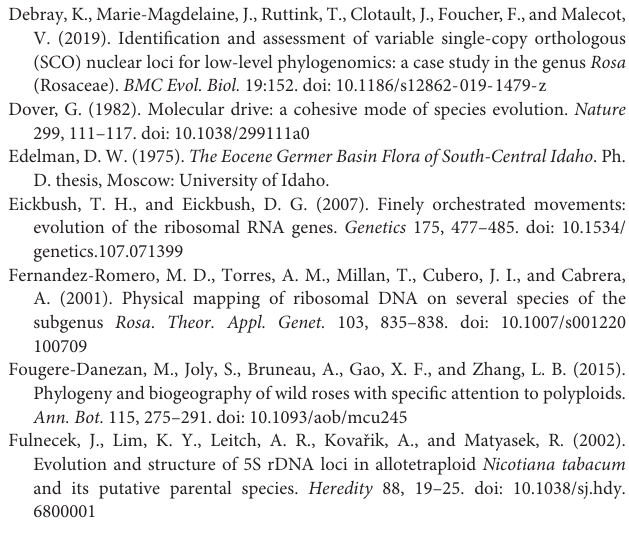
Supplementary Table 3 | Summary of genome proportions and copy number of 5S rDNA families in Rosa genomes. Supplementary Table 4 | Summary of cytogenetic FISH